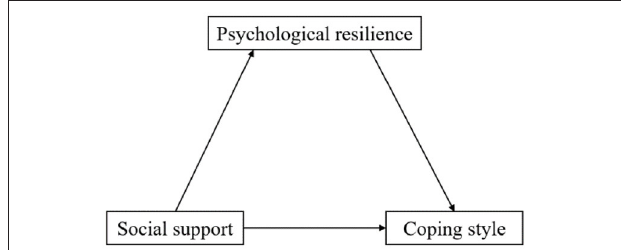
FIGURE 1 | Conceptualized model.